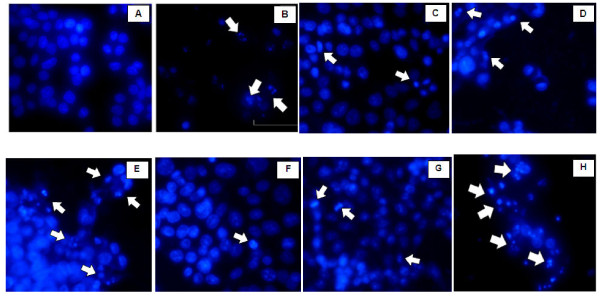
Nuclear morphological changes. Nuclear morphological changes in HepG2 cells after treatment with 2 × IC50 of crude extracts for 24 hours followed by DAPI staining. (A) Control cells treated with media; (B) melphalan-treated group (80 μg/ml). (C-H) cells treated with extracts of: (C) G. daltonii (220 μg/ml); (D) C. orientalis (500 μg/ml); (E) C. speciosum (110 μg/ml); (F) A. villosum (240 μg/ml); (G) A. tatarinowii (500 μg/ml); and (H) Pinus kesiya (110 μg/ml). Arrows indicate apoptotic bodies of nuclear fragmentation observed at 40× magnification under an inverted fluorescence microscope.